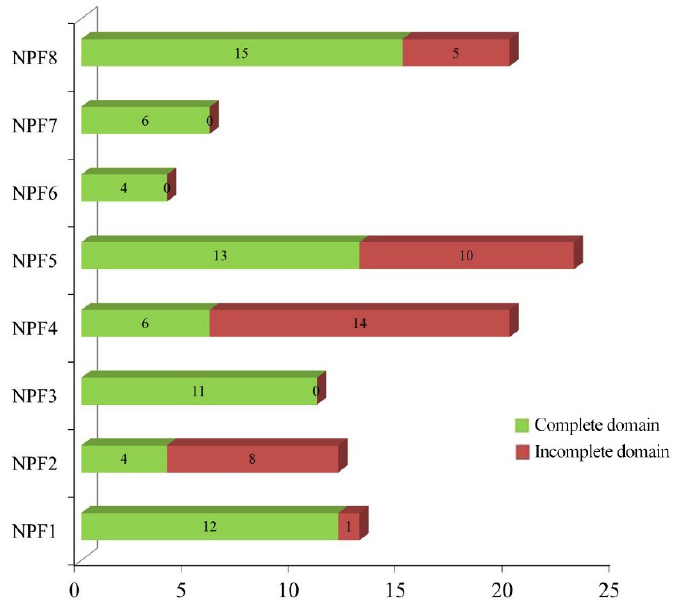
Figure 2. Distribution of CsNPF genes in different subfamilies.